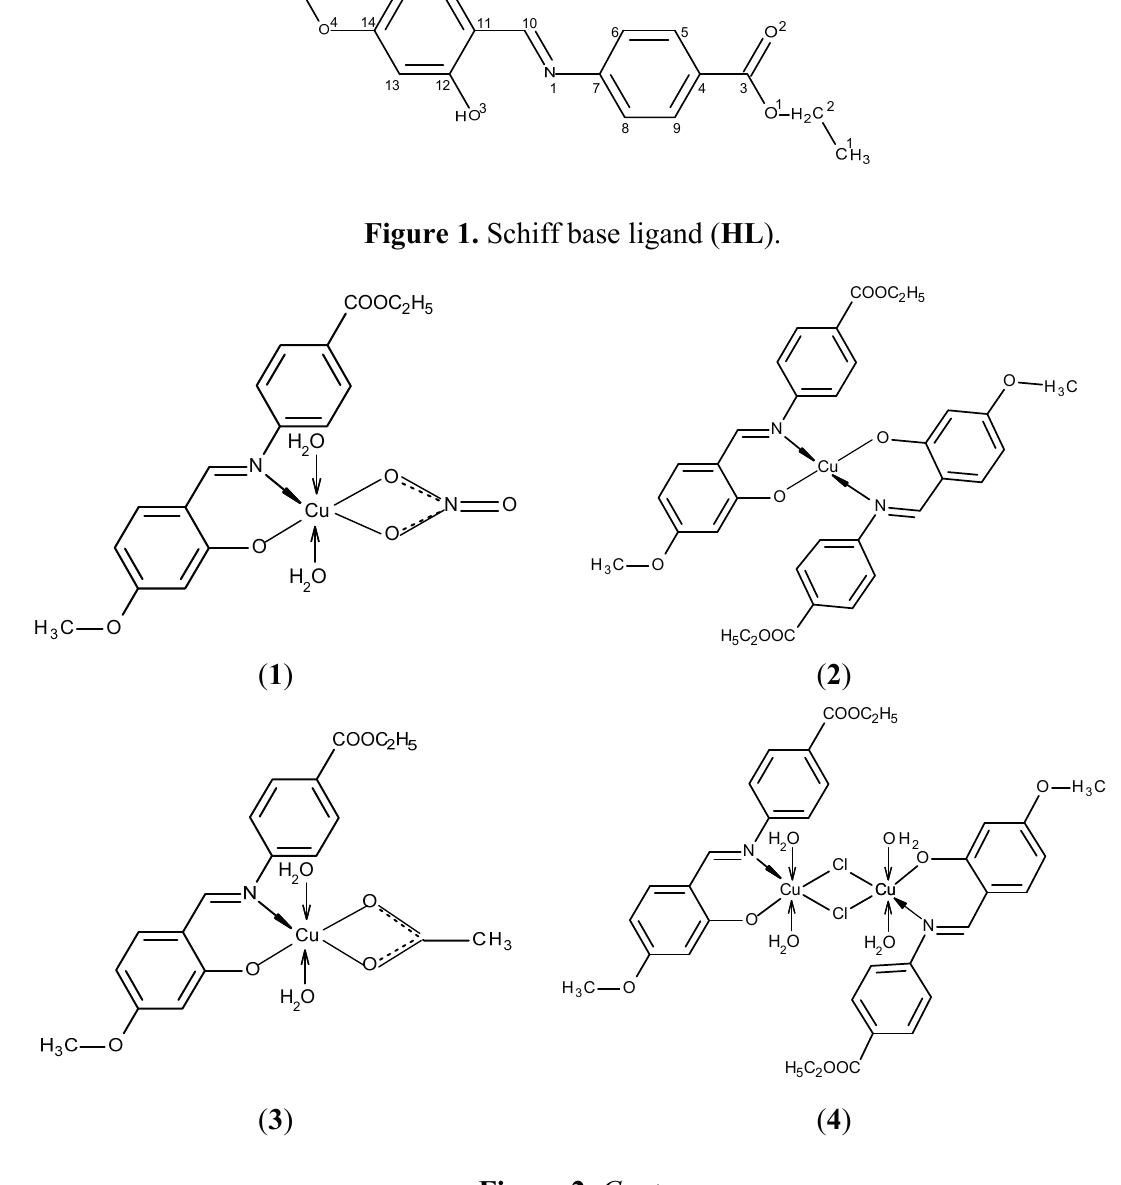
Figure 1. Schiff base ligand ( HL ).